Question: What does this figure show? Answer in one sentence.
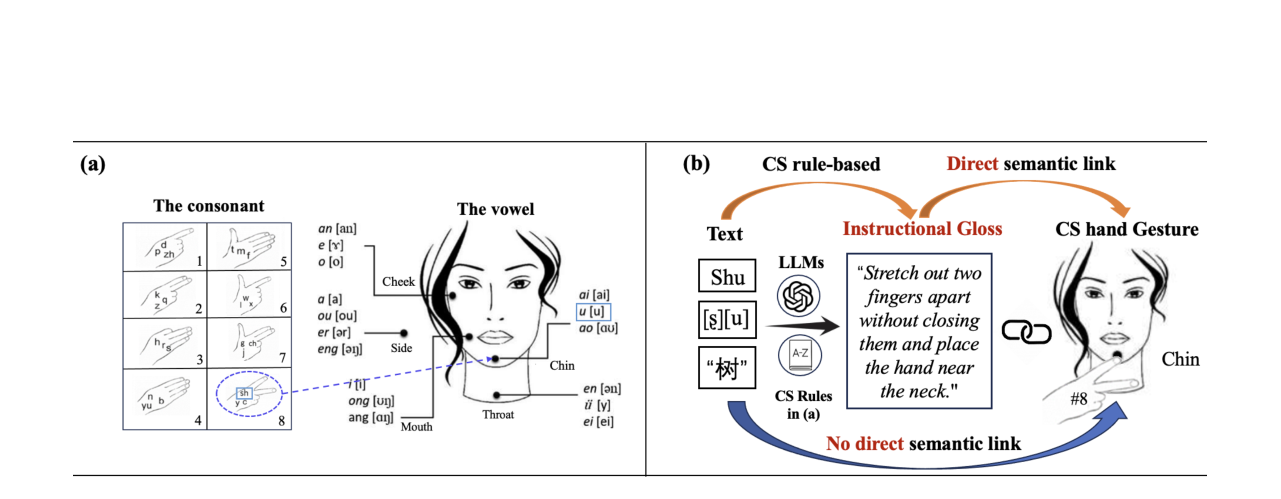
Answer: The details of CS rules and conversion process. (a) is the chart for the Mandarin Chinese Cued Speech (figure from [3]), where five different hand positions are used to code vowels, and eight finger shapes are used to code consonants in Mandarin Chinese. (b) shows the proposed instructional gloss, which directly links the text to the CS movements.